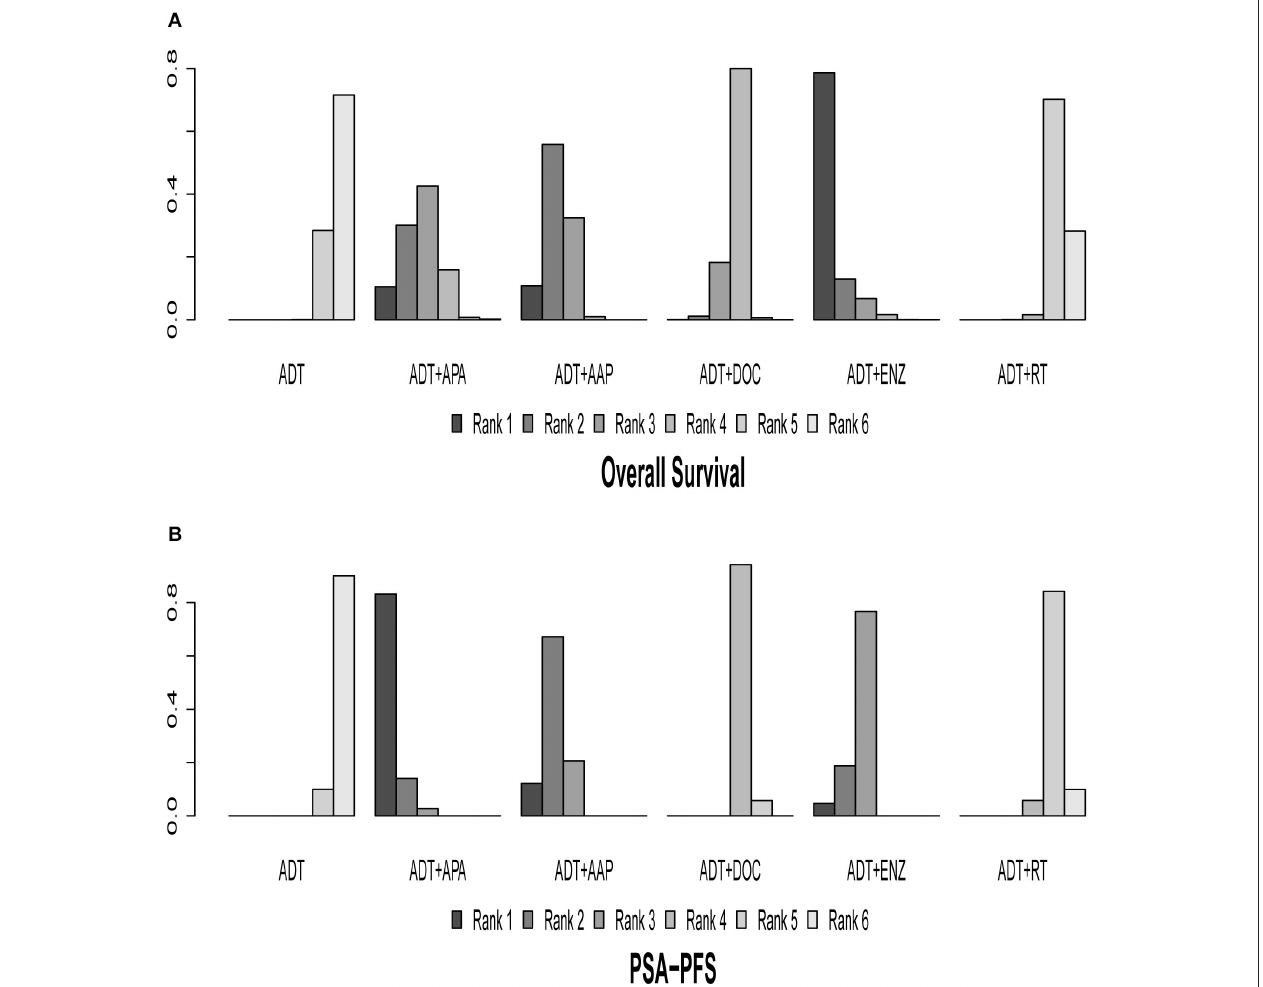
FIGURE 4 | Ranking plot based on the probabilities of interventions in the overall population. (A) OS. (B) PSA-PFS. The height of each column reflects the probability of the